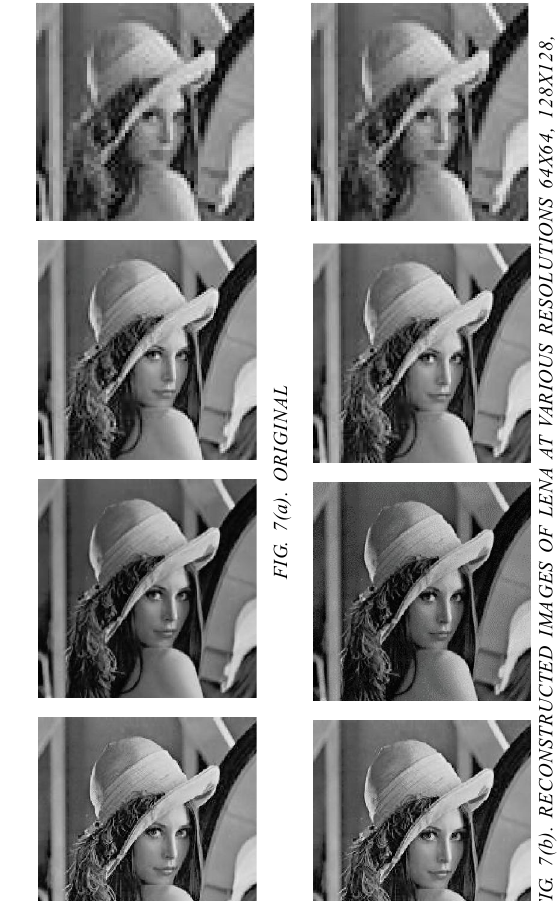
FIG. 5. HISTOGRAM FOR ELAPSED TIME AT GIVEN RATES FOR LENA 512